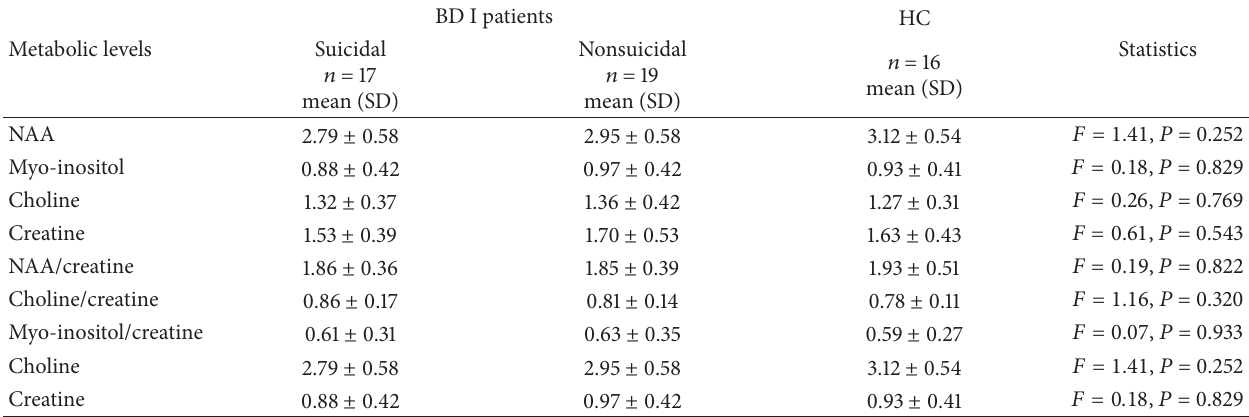
Table 2: Medial orbital prefrontal cortex metabolic levels between bipolar patients with and without suicide attempt and healthy controls (mmol/l ±